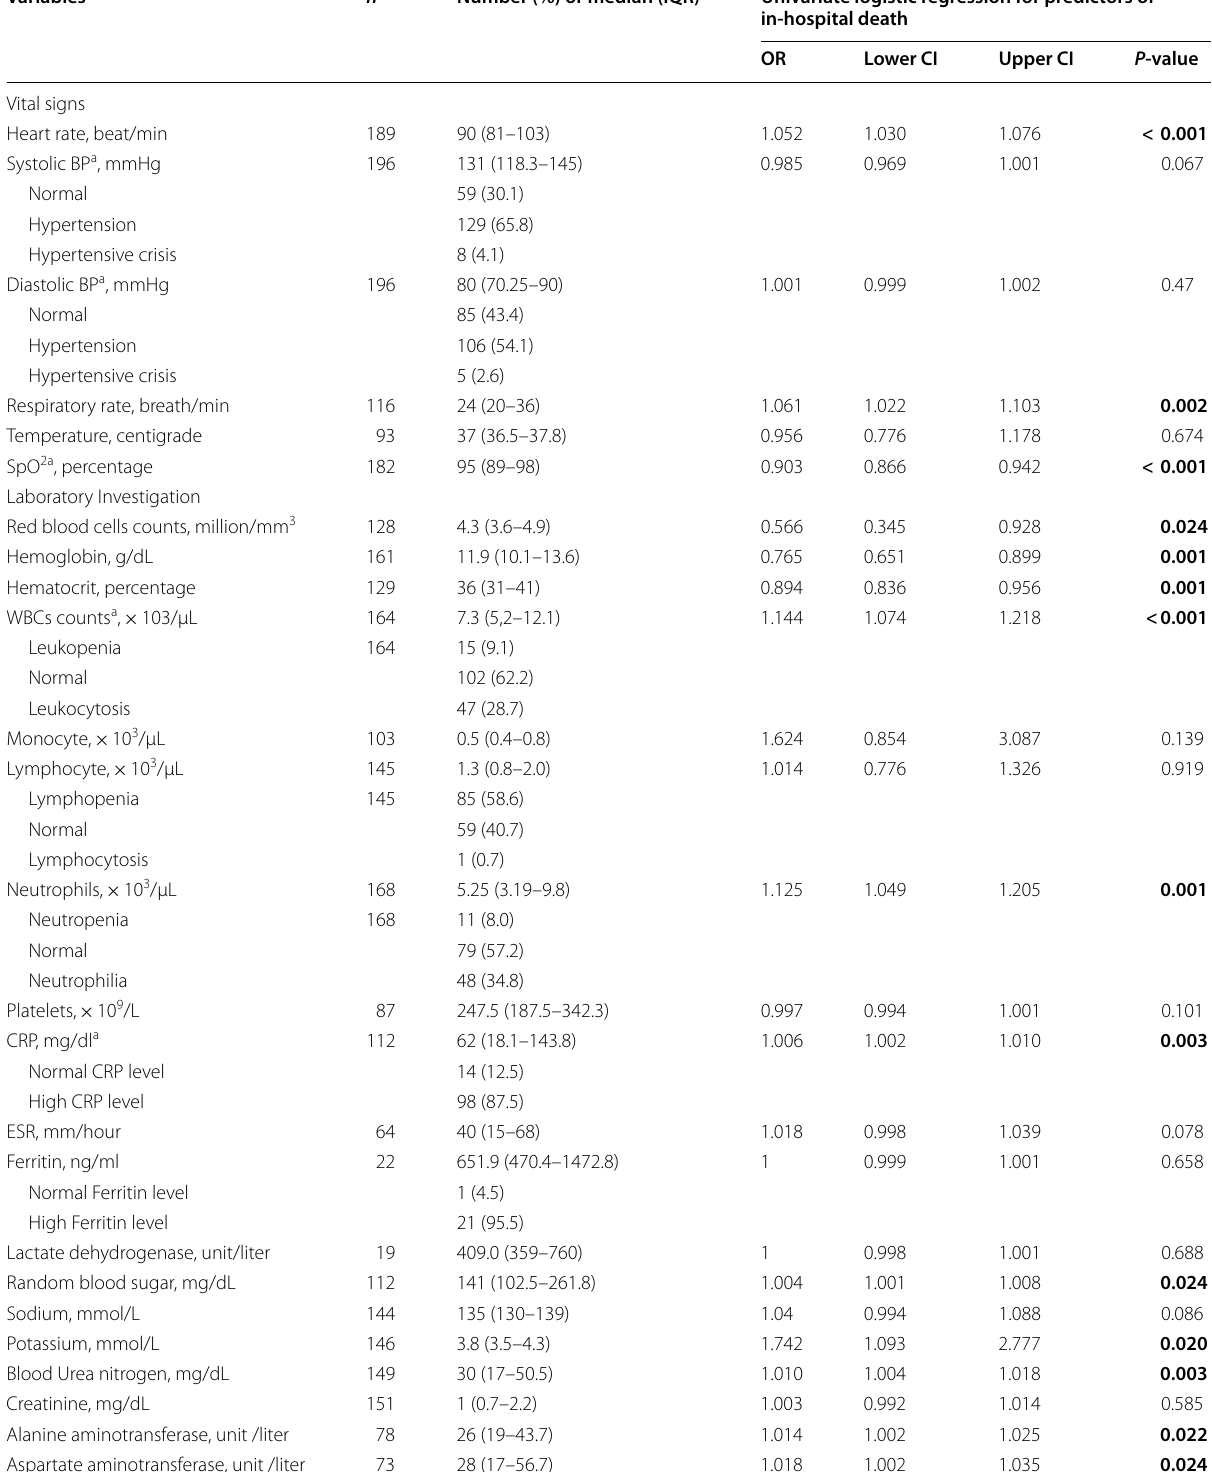
Table 3 Vital signs and laboratory investigations among patients diagnosed with COVID-19 and their association with the final outcome Variables n Number (%) or median (IQR) Univariate logistic regression for predictors of